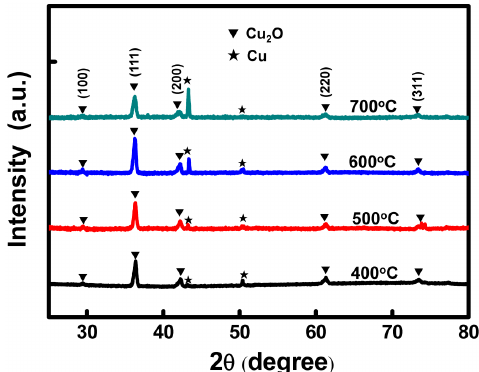
Figure 5. The X-ray diffraction (XRD) analytic results of the Cu 2 O counter electrodes sintered at various temperatures.